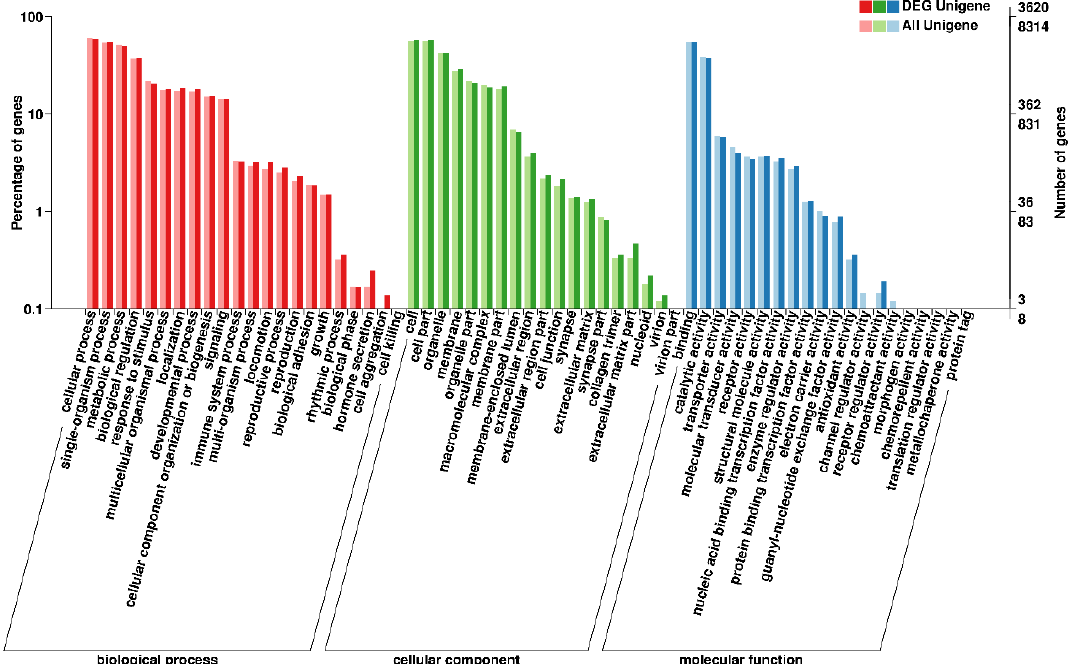
Figure 3. GO classification of the DEGs in the gonadal tissues of male and female Andrias davidianus